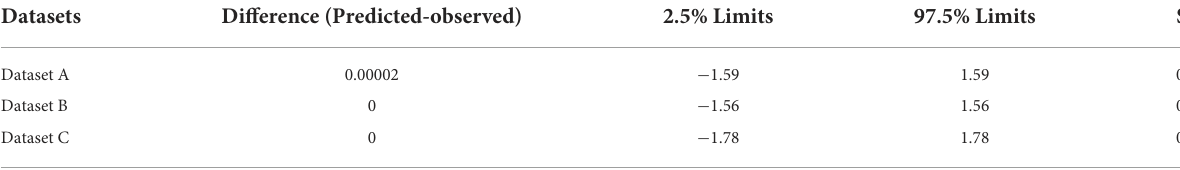
TABLE 4 95% agreement limits of estimated LSM for three datasets in the validation cohort.